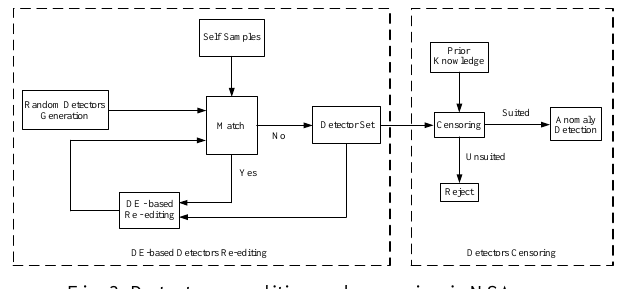
Fig. 3. Detectors re-editing and censoring in